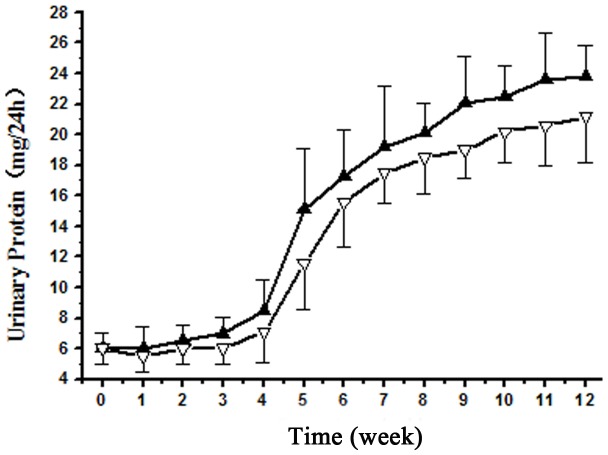
Progression of proteinuria induced by GDF in experimental rats.The urinary protein levels of the proteinuric males (n = 7) and females (n = 4) were shown in solid and empty triangles, respectively.